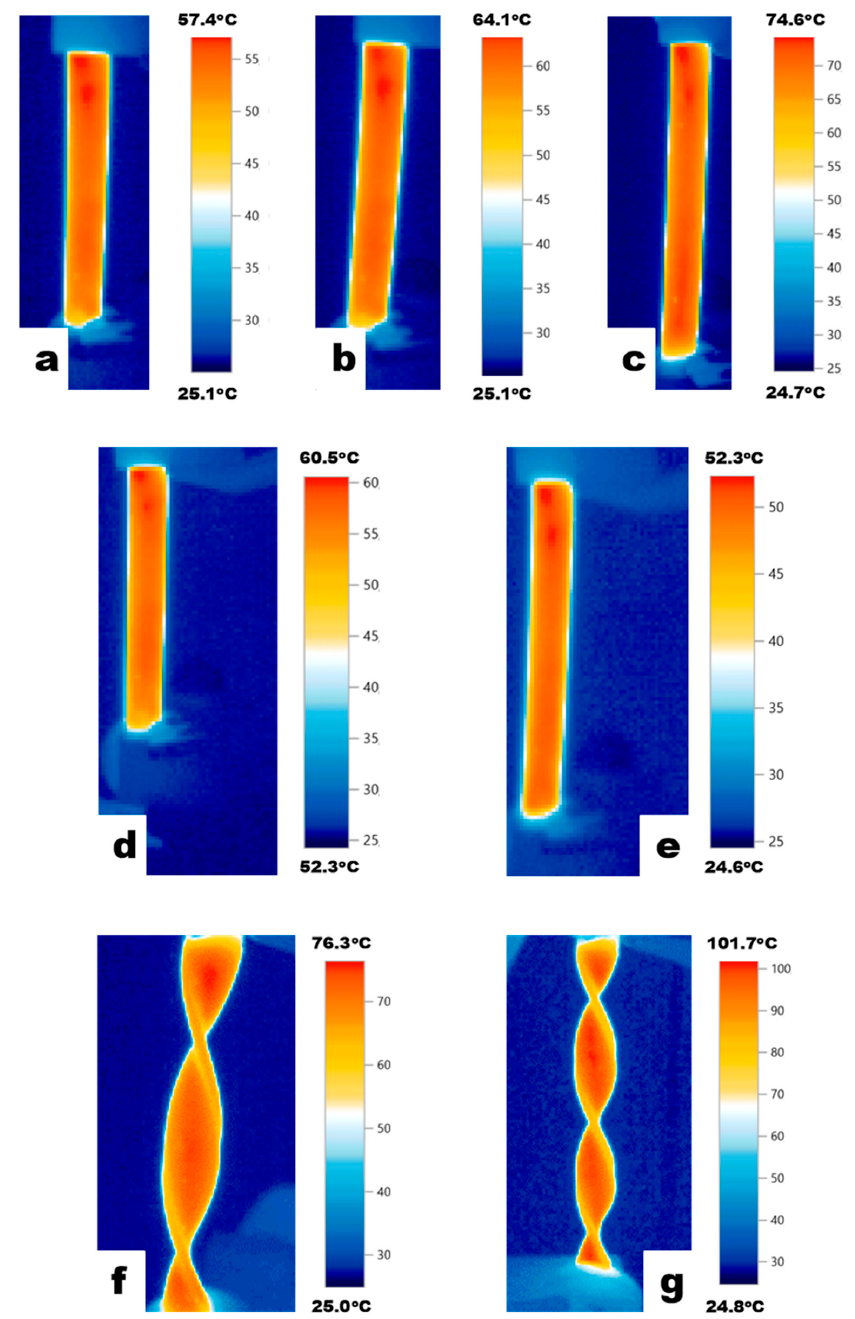
Figure 7. Thermograms of the surface of nanomodified elastomers. ( a – c )—Thermograms of the surface for elastomers with a mass concentration of MNT: ( a )—6, ( b )—7, and ( c )—8 w%. ( d , e )—Thermograms of the surface of nanomodified elastomers: d is the initial sample; e is the sample after stretching by 20%. ( f )—Thermogram of the surface of the nanomodified elastomer at 360° torsion. ( g )—Thermogram of the surface of the nanomodified elastomer at 540° torsion. Differences in the distribution of the temperature field on the surface of the investi- gated elastomer with MWCNTs during tension and torsion are associated with changes in the local electrical resistance in the areas subjected to mechanical deformations, which, on the one hand, is caused by geometric distortion of the dielectric matrix, and, on the other hand, by deformation of MWCNTs. At the same time, the stretching of the